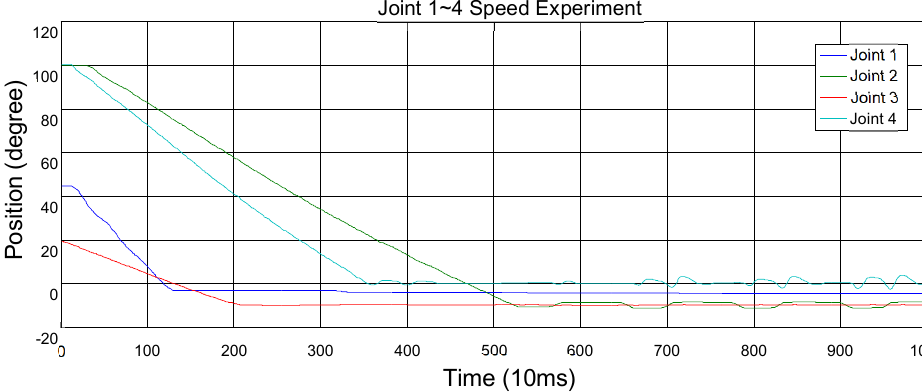
Figure 17. Four axes—curve of position drop versus time.